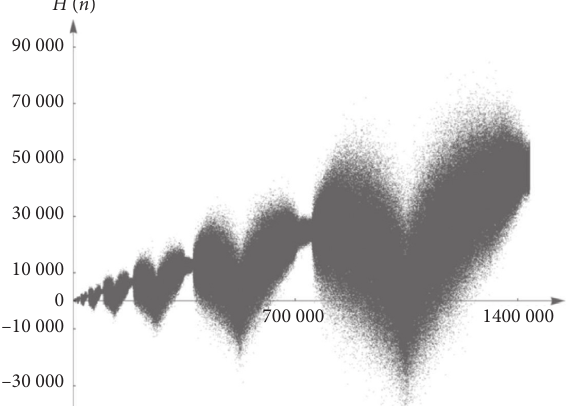
Figure 2: H ( n ) � C ( n ) − Q ( n ) for n from 1 to